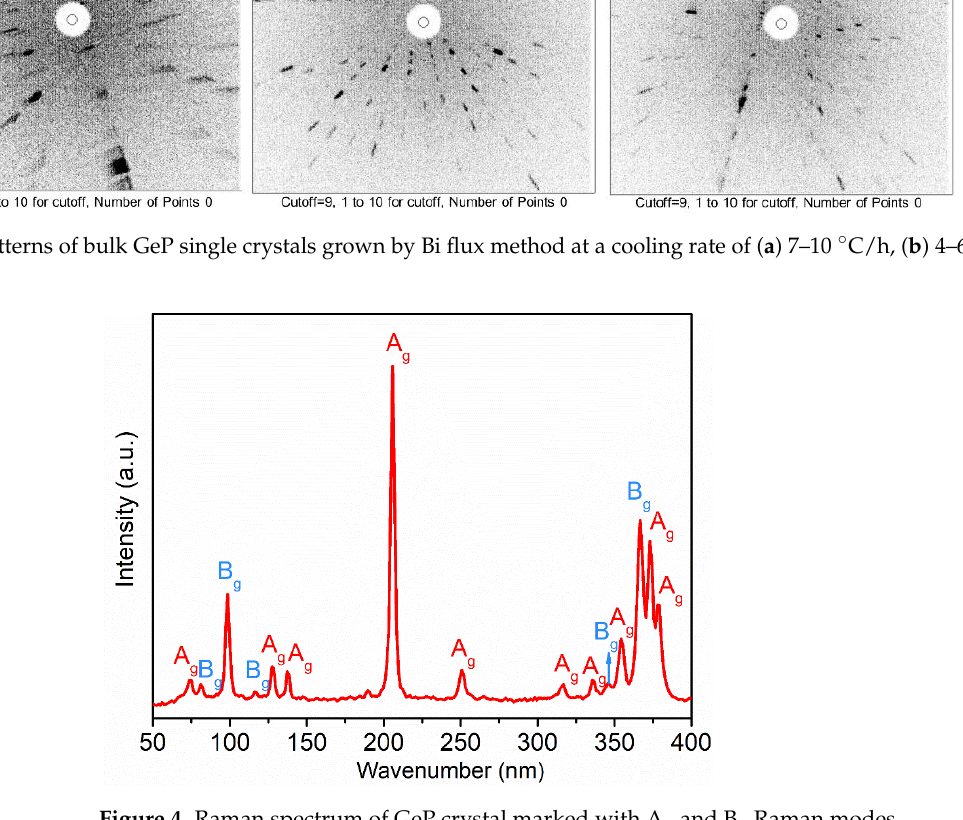
g and B g Raman modes.